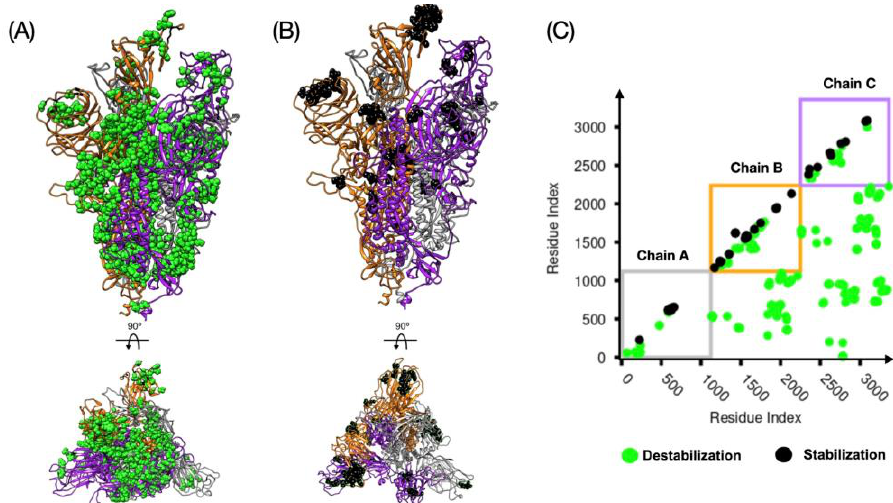
Panel ( A ) shows the structure of the homotrimer and in green the amino acid residues that destabilize the spike protein in this conformation. The bottom of panel ( A ) shows the same structure rotated by 90 ◦ as indicated, showing that most of the destabilizing residues are positioned between the RBD (in up position) from chain B and the RBD and NTD from chain A. Panel ( B ) shows the stabilizing residues in black. Panel ( C ) shows the plot of the contact map. The squares follow the color convention for each protomer and each dot represents a high-frequency contact (i.e., green = destabilizing and black = stabilizing).